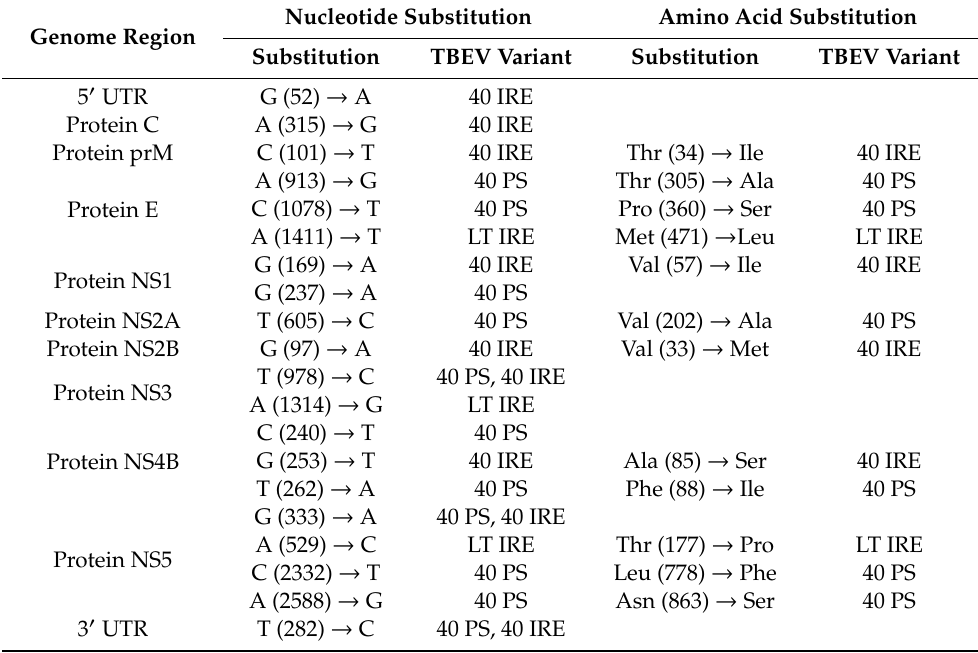
Table 1. Genetic di ff erences between the parental tick-borne encephalitis virus (0 P) and